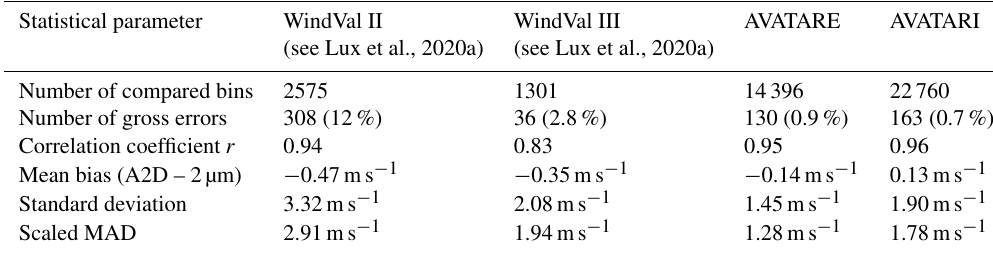
Table 4. As in Table 3 but for the statistical comparison between the A2D Rayleigh and the 2µm LOS wind